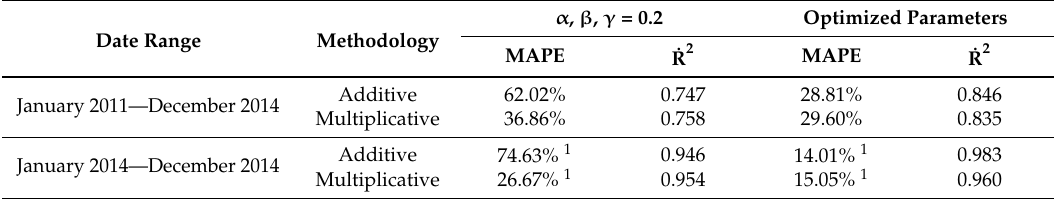
Table 5. Error measurement for Holt-Winters exponential smoothing forecast.